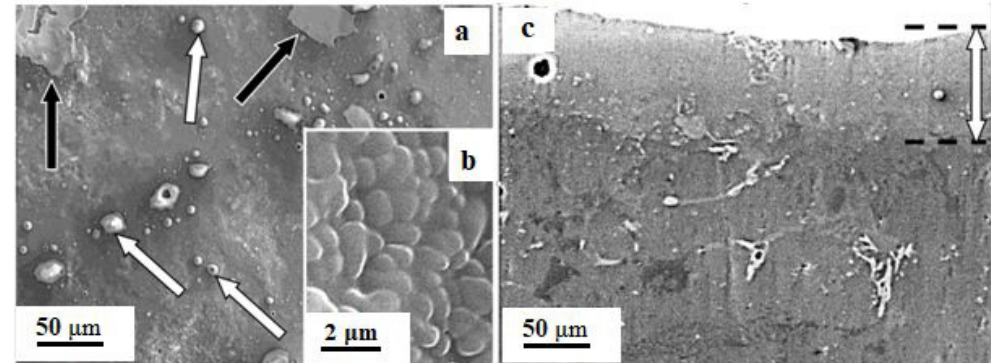
Figure 1. Structure of Al-11wt%Si alloy subjected to electroexplosion alloying and subsequent irradiation by pulsed electron beam; a, b – structure of irradiation surface; c – structure of transverse etched metallographic section. In (a) the dark arrows designate the films, the light arrows – the microdroplets located on the surface of the sample; in (c) – modified layer. Scanning electron